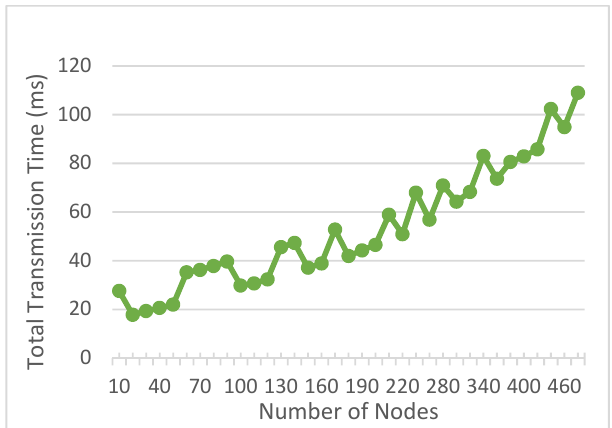
Figure 8. The total transmission time vs. the number of nodes for the PoW model.